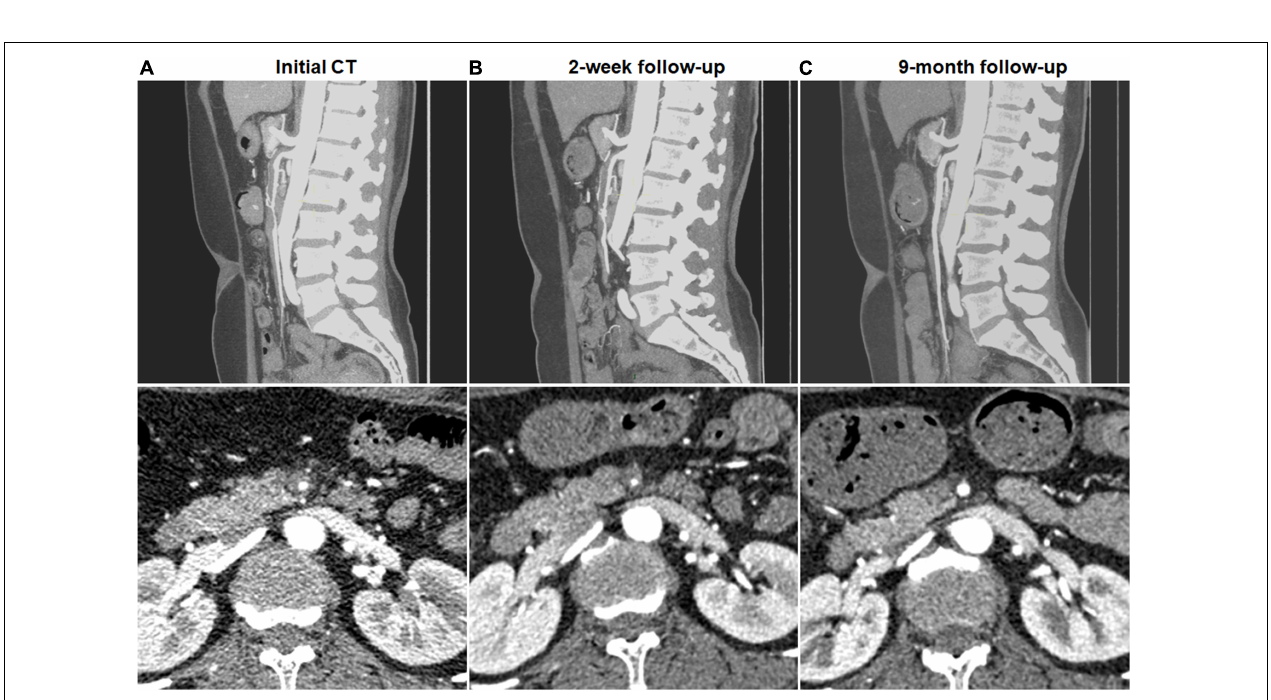
FIGURE 3 | Complete remodeling of type IV spontaneous isolated superior mesenteric artery dissection on follow-up computed tomography (CT) angiography. (A) Initial CT angiography showed the completely thrombosed false lumen in a 44-year-old woman. (B) Two weeks later, false lumen thrombus became thickened, and stenosis of true lumen was aggravated. (C) Nine months later, false lumen thrombus was completely resolved, and type IV dissection achieved complete remodeling.